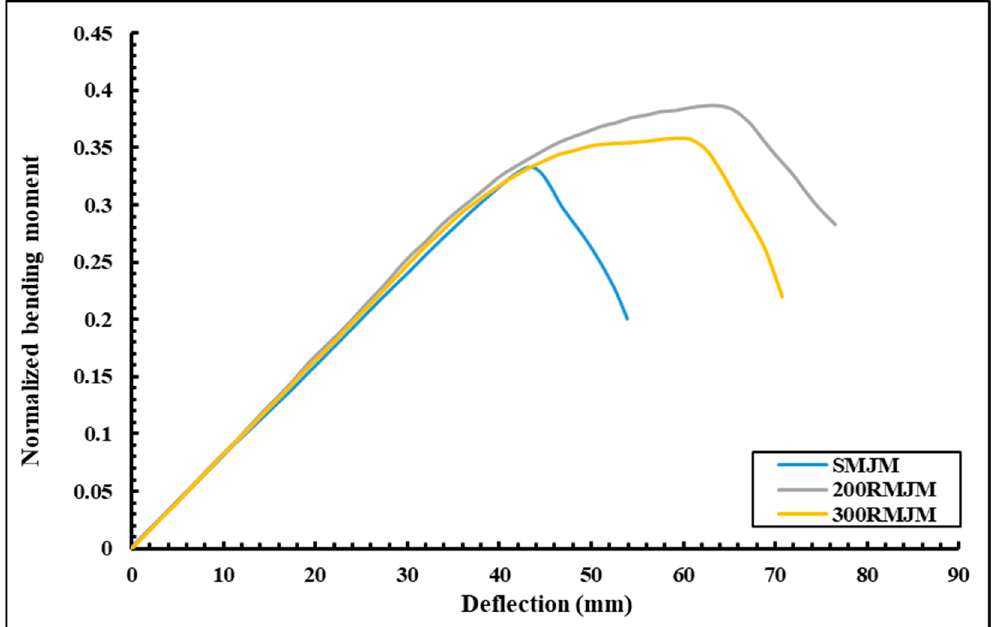
Figure 14. The normalized major axis test average curves.